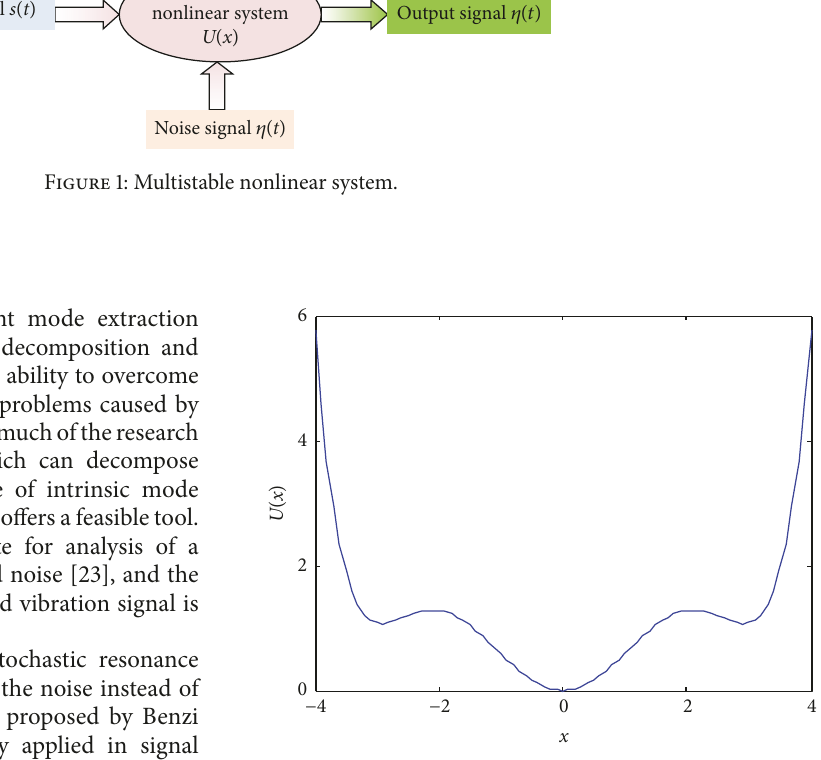
Figure 2: The multistable potential function 𝑈(𝑥)